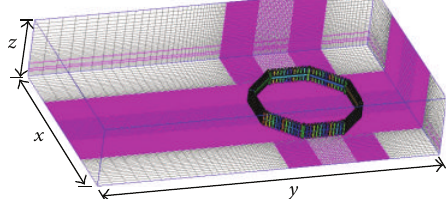
Figure 3: The analyzed domains of